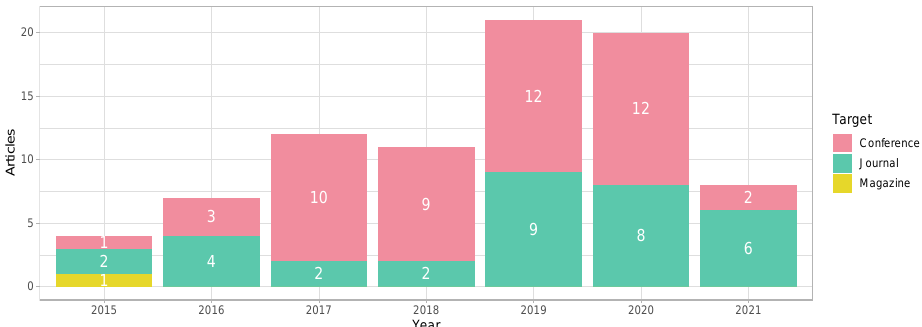
Figure 2. Number of studies related to Cloud-based indoor positioning per